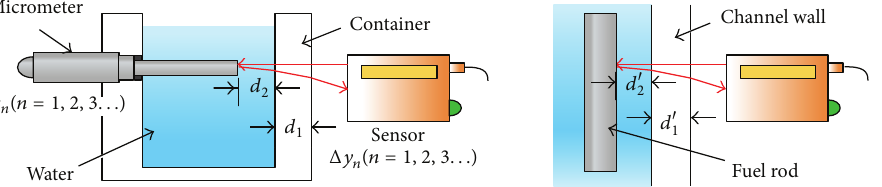
Figure 7: Measurement calibration device.